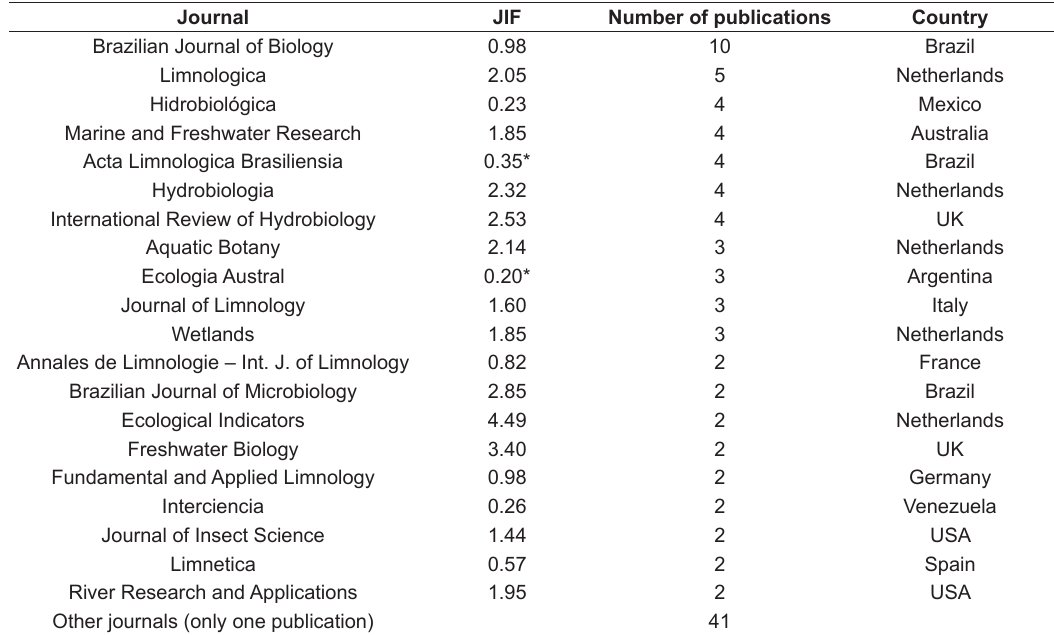
Table 1. Journals with more than one publication on decomposition in subtropical South American aquatic environments, during the period between 1990 and 2018, using the Scopus and the Web of Science databases.